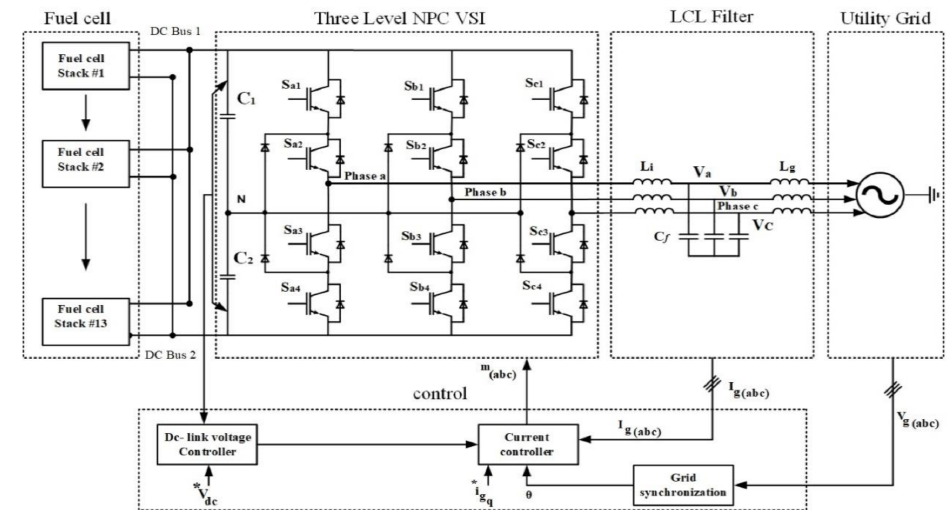
Figure 3. The grid-tied fuel cell